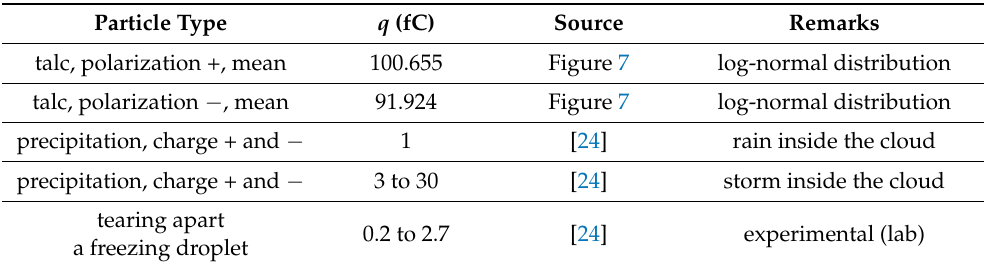
Table 2. Particle electric charges for different materials and